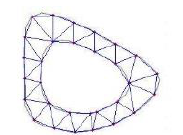
Figure 9 . Delaunay triangulation